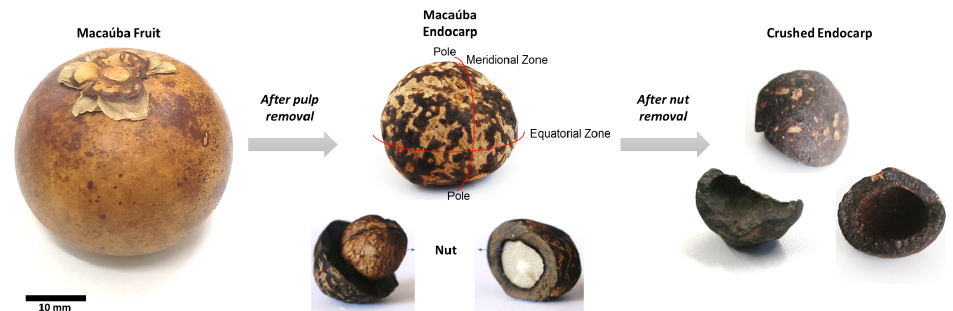
Figure 4. Bio-aggregate: from Macaúba fruit to crushed